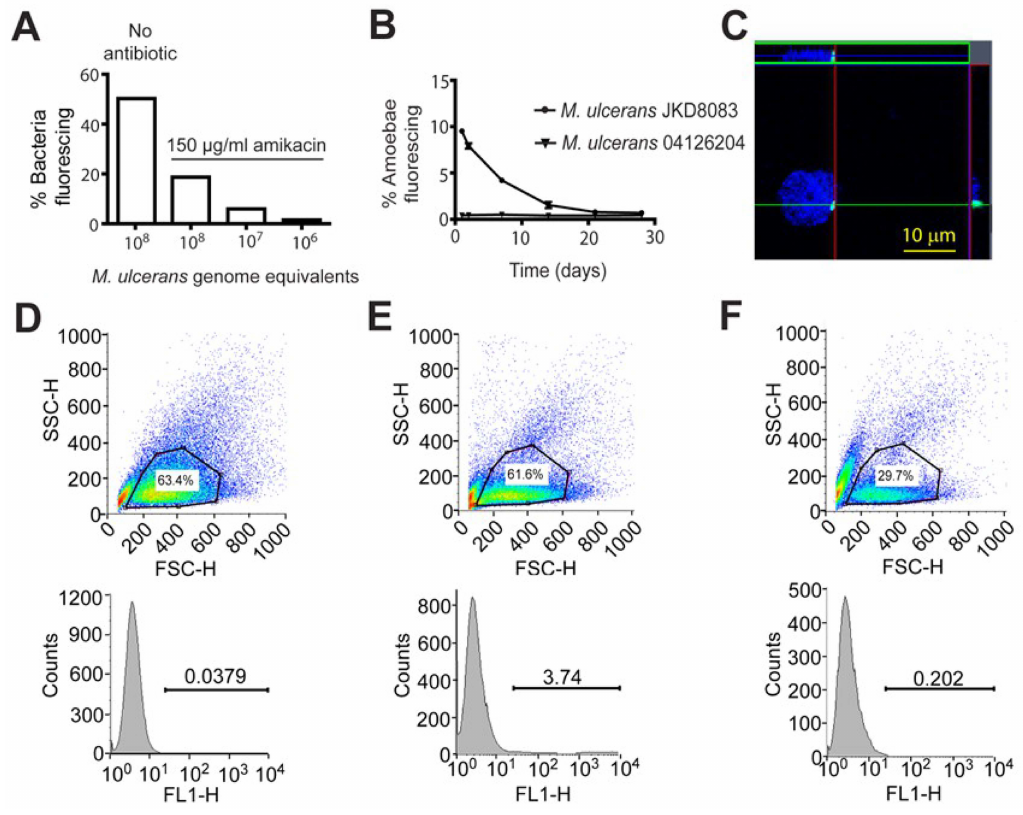
Figure 3. ( A ) Percentage of fluorescing bacteria present following growth at room temperature for 7 days in AC buffer supplemented with 150 m g/ml amikacin. ( B ) Summary of flow cytometry data of A. castelanii infected with fluorescing (JKD8083) and non- fluorescing (04126204) M. ulcerans for 28 days. The mean percentage and SD of 3 biological repeats of fluorescent trophozoites at a MOI of 1 are shown. ( C ) Confocal microscopy demonstrating the intracellular location of M. ulcerans 3 hours post-infection in a DAPI stained trophozoite. Scale bar indicates 10 m m. ( D–F ) Representative FACS plots indicating forward scatter (x-axis) and side scatter (y-axis) following 7 days of co-incubation of amoebae alone ( D ), M. ulcerans JKD8083 ( E ) and M. ulcerans 04126204 ( F ). Lower panels show the gated trophozoites and FL1 fluorescence vs counts. Numbers refer to percentage of gated trophozoites fluorescing.